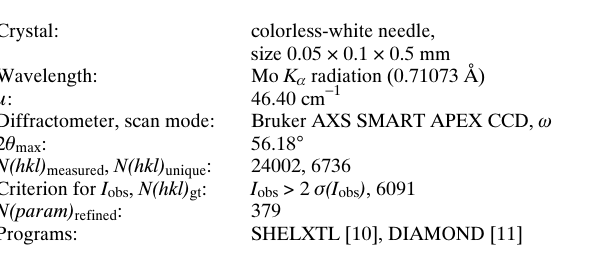
Table 1. Data collection and